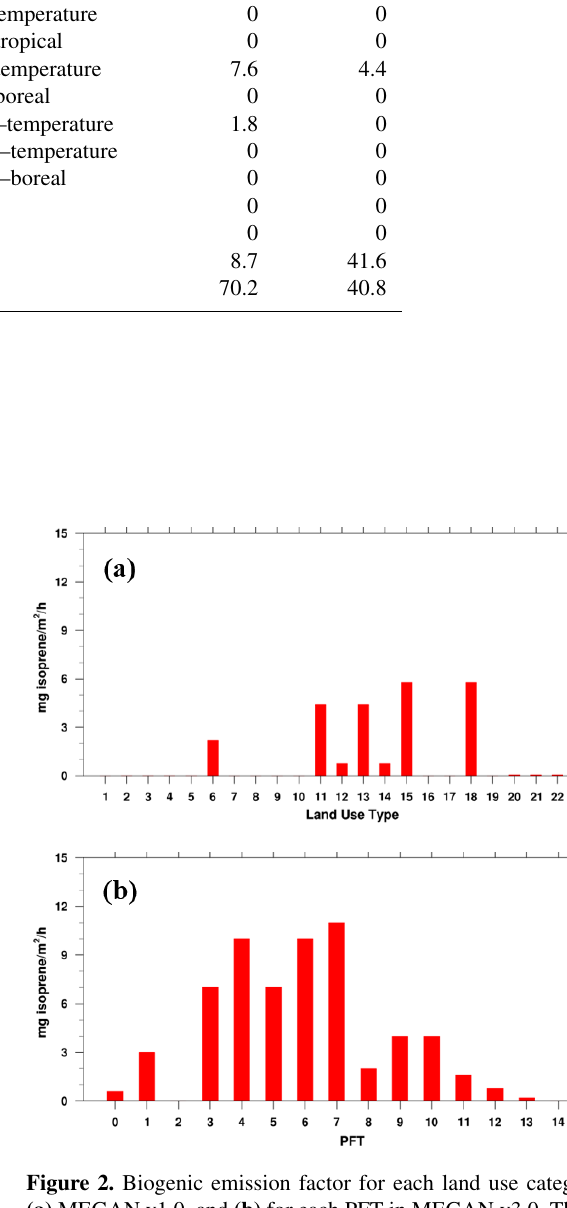
Figure 1. Spatial distribution of two different vegetation datasets (VEG-USGS and VEG-2015) and dominant PFT derived from them in each grid over the simulation domain.